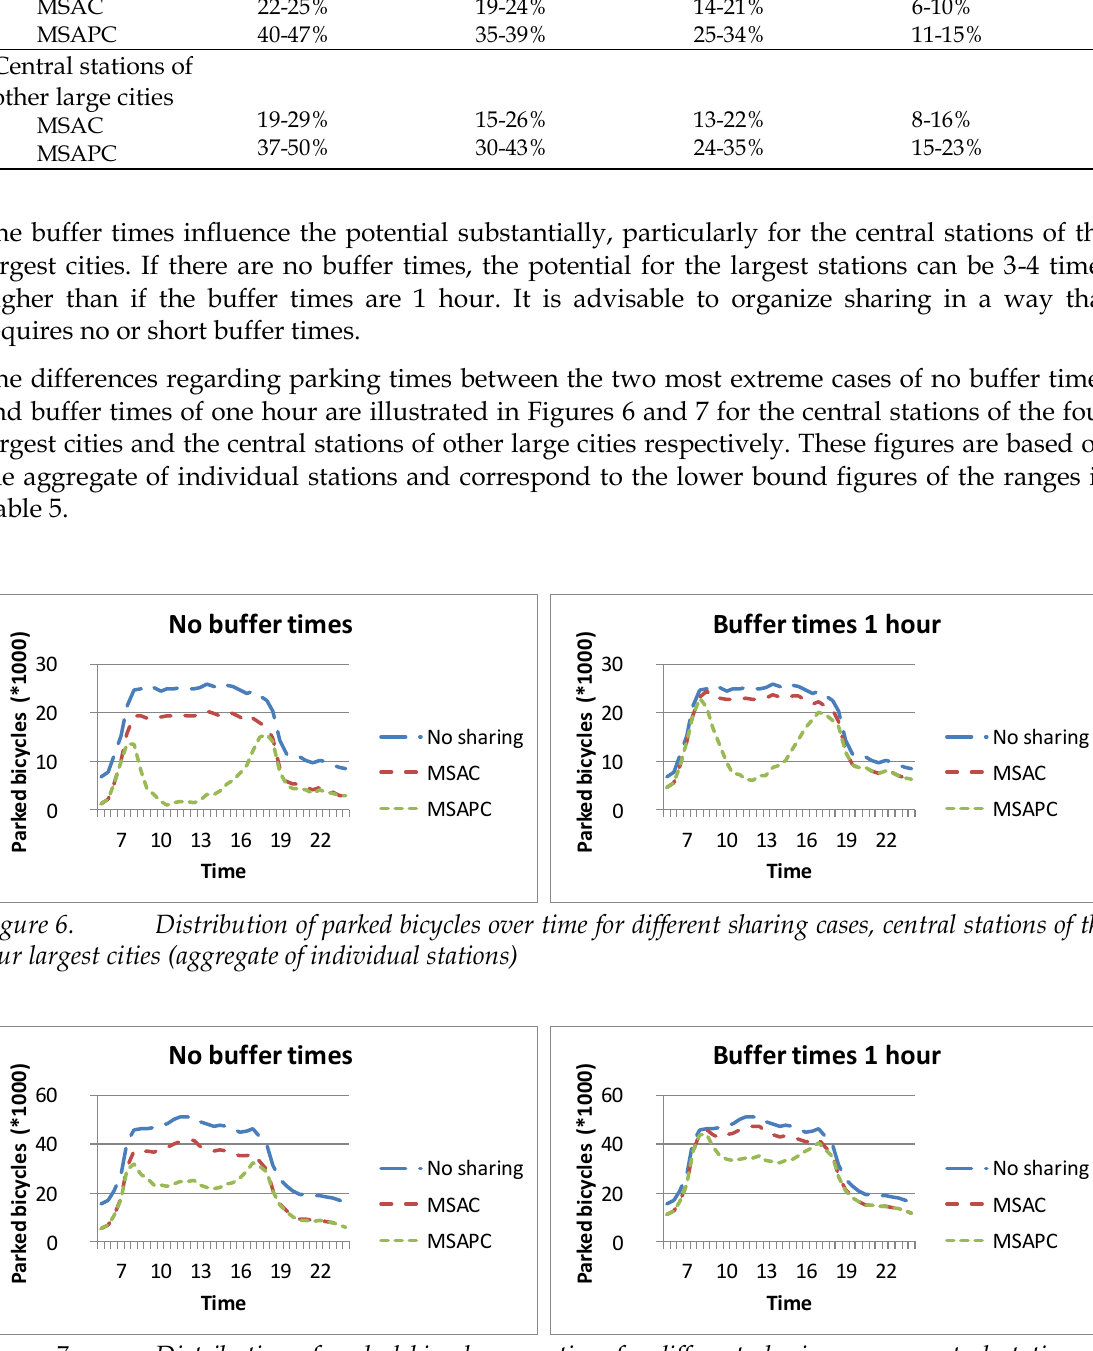
Figure 7. Distribution of parked bicycles over time for different sharing cases, central stations of other large cities (aggregate of individual